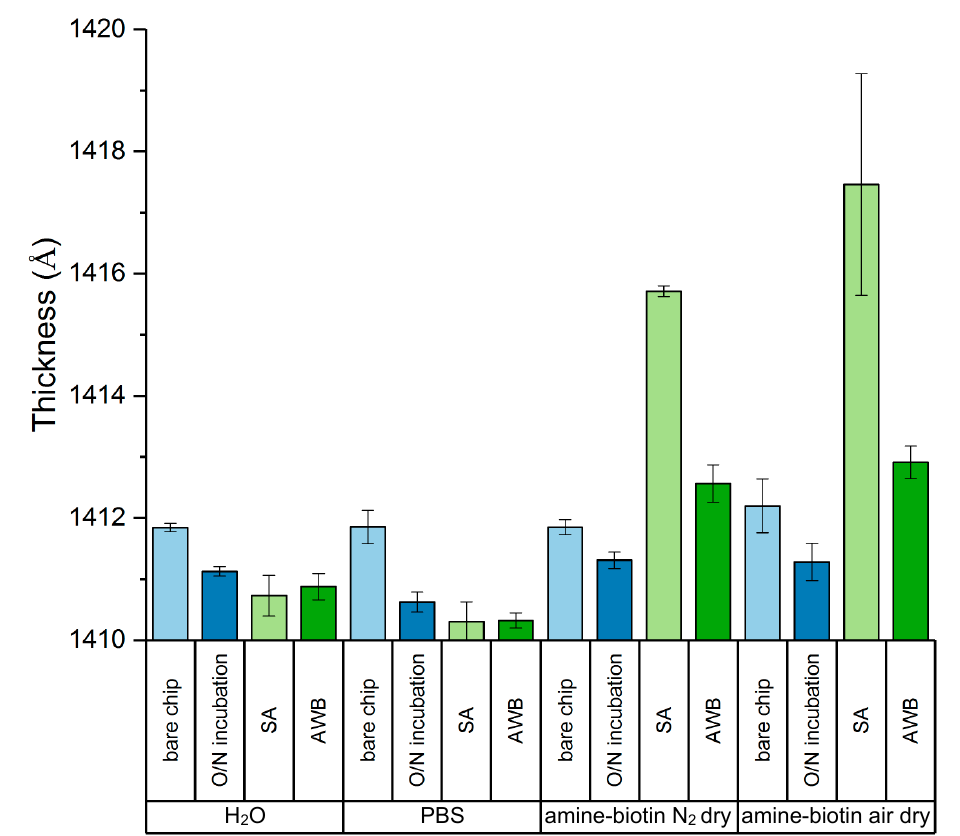
Figure 1. Growth of the biotin–streptavidin lawn. The overnight (O/N) incubation conditions were H 2 O, PBS, or a mixture of amine-PEG 11 -biotin and amine-PEG 4 -methyl. Thicknesses are the averages of three chips measured via ellipsometry and fit to a model of silicon dioxide layer on silicon substrate after each step of the growth process. Error bars represent the standard deviation of thickness measurements between three replicate chips. All chips were washed with Nanopure TM water and dried with a nitrogen gas stream after each incubation and prior to ellipsometry except after streptavidin where one set of chips (indicated above) was allowed to dry in ambient air on the laboratory benchtop. Streptavidin only builds onto the chips exposed to amine–biotin, and a significant loss of surface thickness is observed after drying and rewetting with assay wash buffer (AWB) after either drying condition.